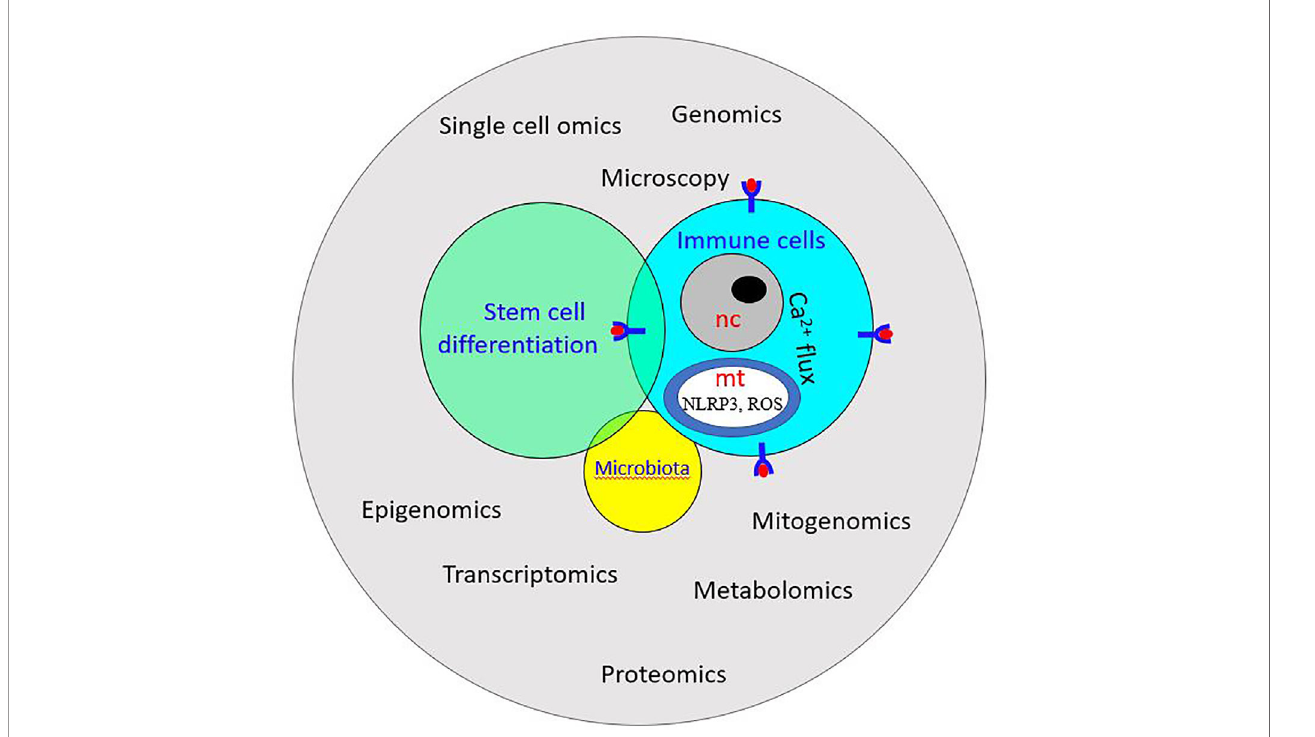
FIGURE 9 | Schematic illustration of system biology: it exploits -omics technology to study the interplay among stem cells, immune cells, and microbiota. ROS, Reactive oxygen species; NLRP3, NOD-like receptor P3; nc, nucleus; mt, mitochondrion.